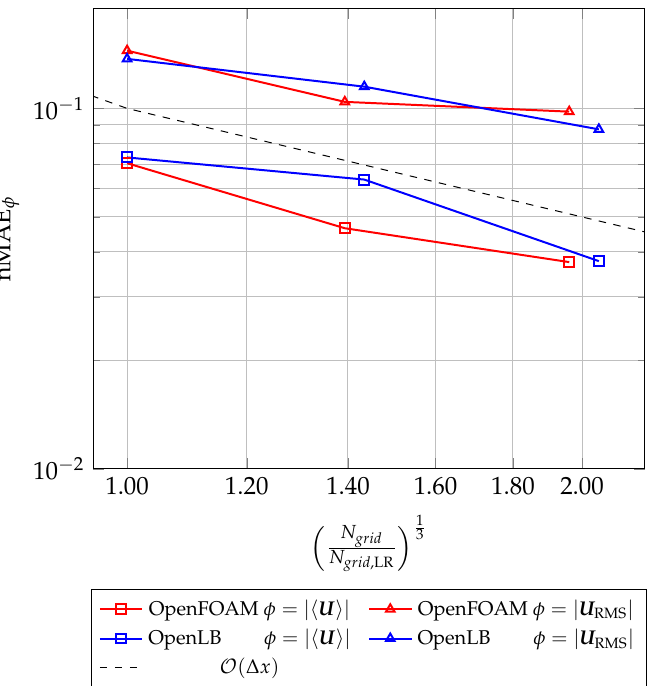
and the RMS and the RMS U U |h i| |(cid:104) (cid:105)|